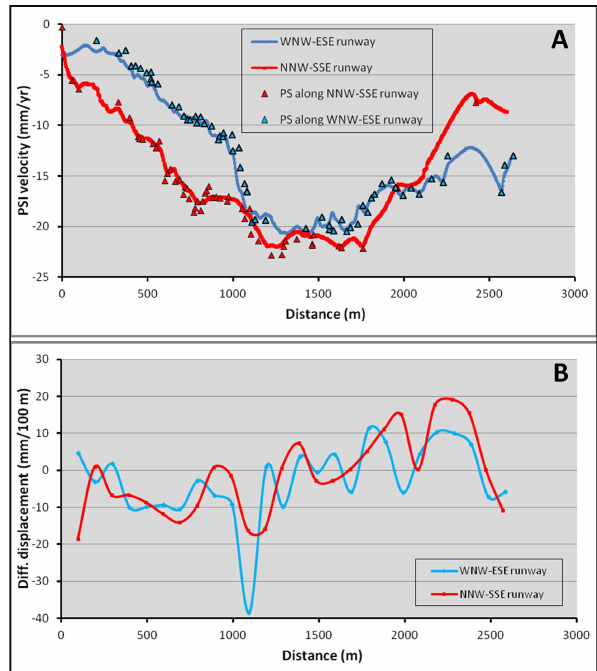
Fig. 8. Vertical deformation (Vv) of the LOS velocities measured along the runway areas of the Thessaloniki airport (A) . Differen- tial displacement along the runways area (B) . Origin is set on the